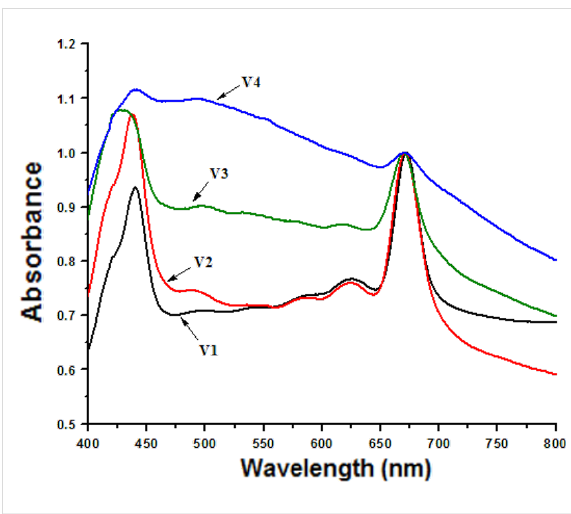
Figure 3: The VIS absorption spectra of Chl a in biomimetic membranes and in bio-hybrids.